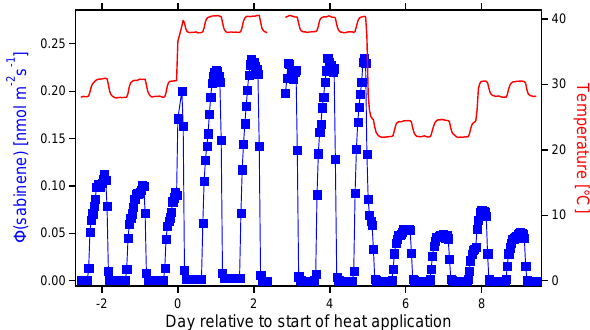
Fig. 1. Sabinene emissions (blue squares, left y-axis) from a beech. The red line indicates temperature (right y-axis). PPFD=800/0µmolm − 2 s − 1 ,